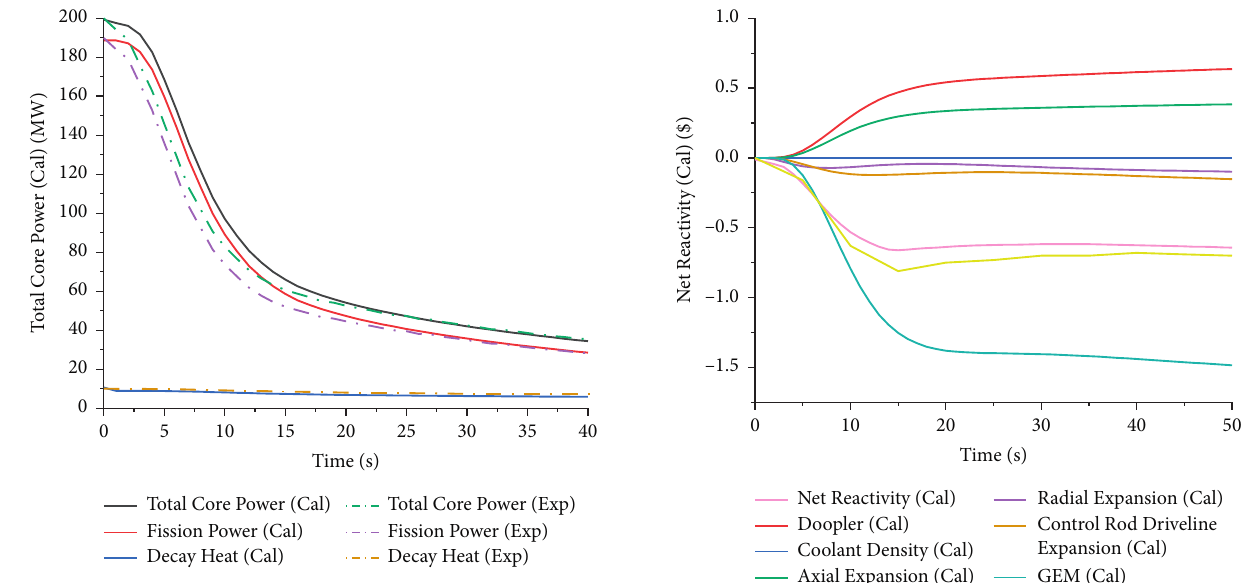
Figure 18: Reactor power of FFTF LOFWOS test #13 (0s–40 s).